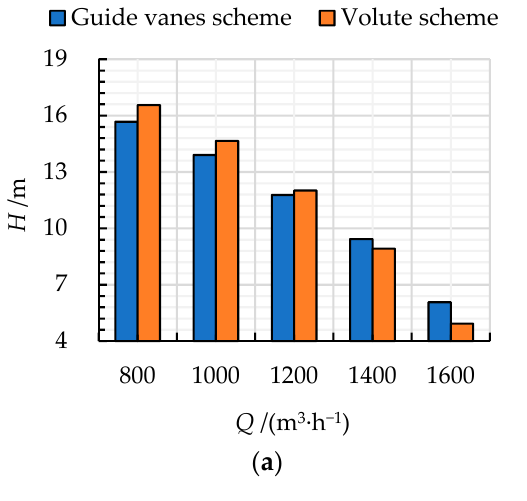
Figure 6. Comparison of the ( a ) head and ( b ) efficiency of the mixed-flow pump under guide vanes and volute scheme.